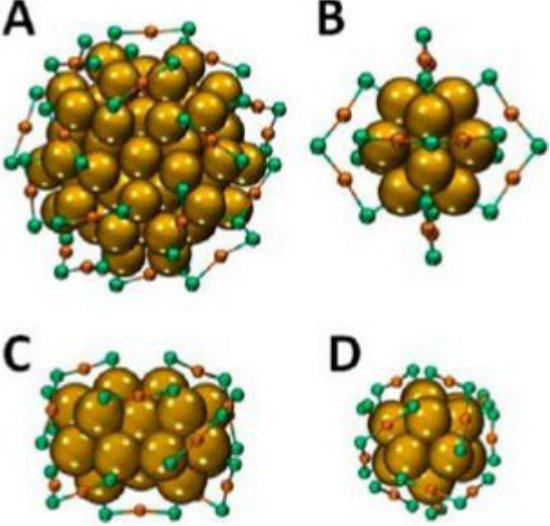
Figure 2. Chirality and crystal structures of the Au (p-MBA) cluster (p-MBA: 102 44 p-mercaptobenzoic acid) ( A ); Au (2-PET) cluster (2-PET: 2-phenylethylthiolate) ( B ); 25 18 and Au (2-PET) in side view ( C ) and along its principal axis ( D ). For the latter, the 38 24 left-handed A-enantiomer is shown. The organic groups are removed. Yellow, Au ; core orange, Au ; green, sulfur. Reprinted with permission from [27]. Copyright 2013, Adatom American Chemical Society.